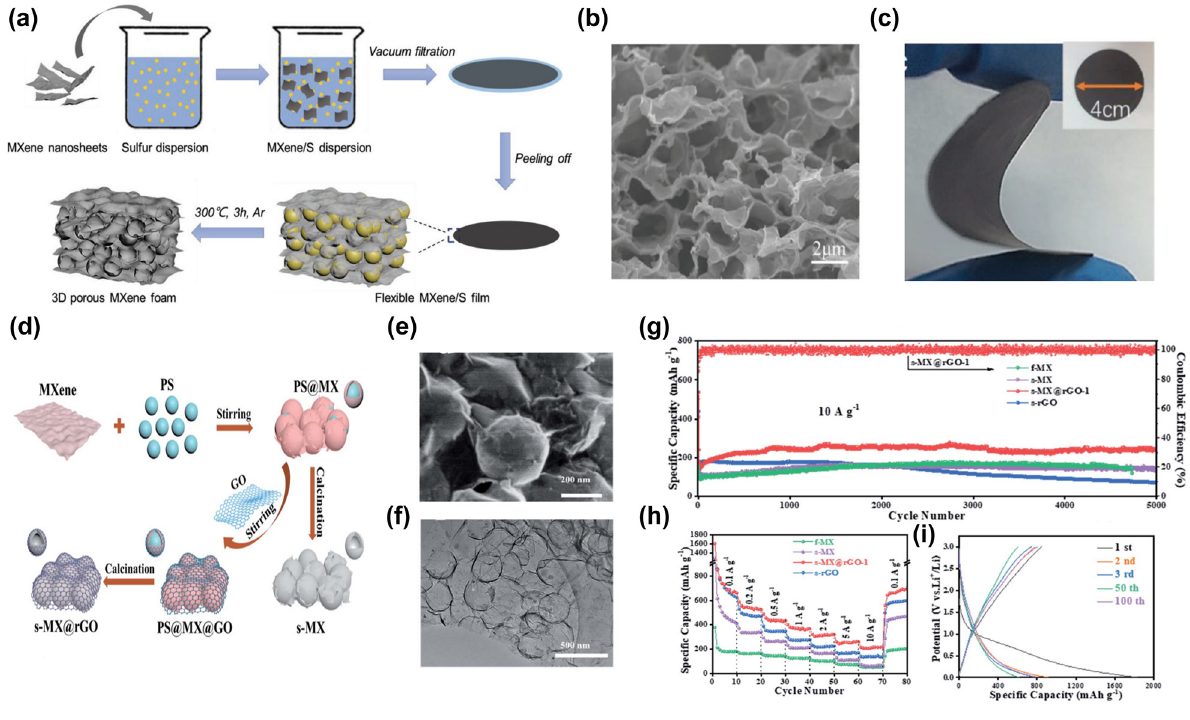
Figure 4: Preparation process, structure and electrochemical performance of flexible 3D MXene foam. (a) Schematic illustration of the preparation process of the freestanding and flexible 3D porous MXene foam. (b) SEM images and (c) digital photo of p-MXene-71. Reproduced with permission [84]. Copyright 2019, WILEY-VCH. (d) Schematic illustration of the fabrication process of the s-MX@rGO composite. (e,f) SEM and TEM images of s-MX@rGO-1. (g) long-term cycling properties at 10 A g − 1 for 5000 cycles; (h) rate capability at various current densities (0.1 A g − 1 –10 A g − 1 ). (i) Charge/discharge curves of the s-MX@rGO-72 electrode in different cycles at 100 mA g − 1 . Reproduced with permission [85]. Copyright 2021, The Royal Society of